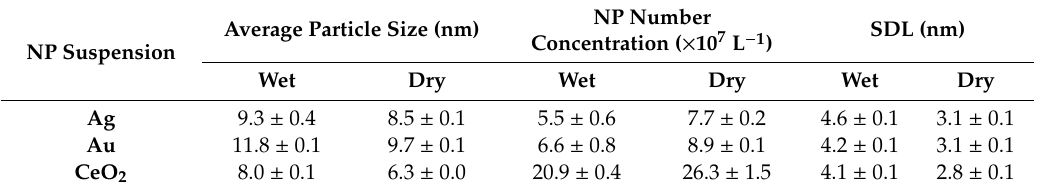
Table 2. Average particle sizes, number concentrations and SDL in 10 ng L − 1 suspensions of Ag, Au and CeO 2 NPs. Means and standard deviations are obtained from the analysis of triplicate samples.